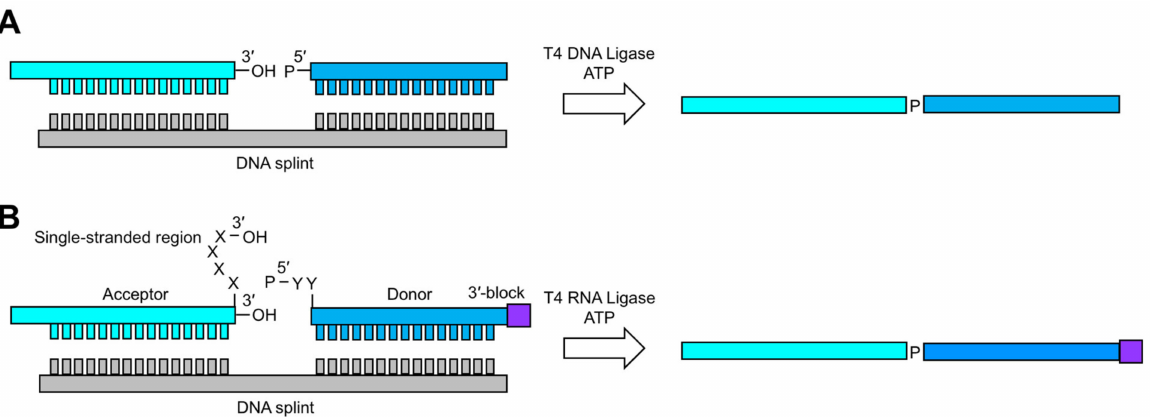
Figure 5. Enzymatic RNA ligation [19,99]. DNA splinted ligation schemes are shown using ( A ) T4 DNA ligase and ( B ) RNA ligase. Shown in B are the optimized 3 (cid:48) -end linker and 3 (cid:48) -end block of the donor and acceptor fragments, respectively. Sequence requirements for T4 RNA Ligase are also shown. Additional details can be found in earlier works